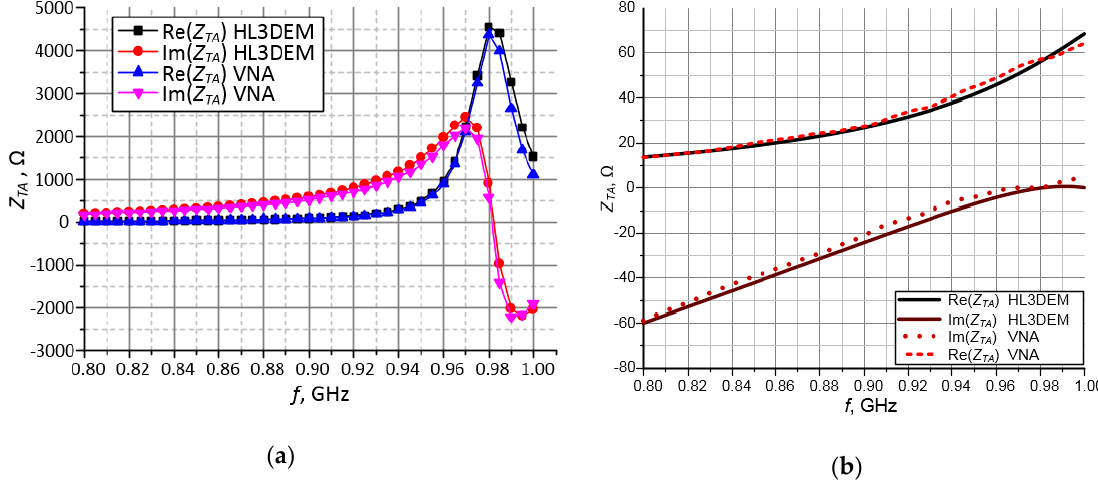
Figure 22. Results of experiments: ( a ) Transponder designed to laboratory tests—Figure 21a; ( b ) Transponder dedicated to work as the RFID sensor—Figure 21b.